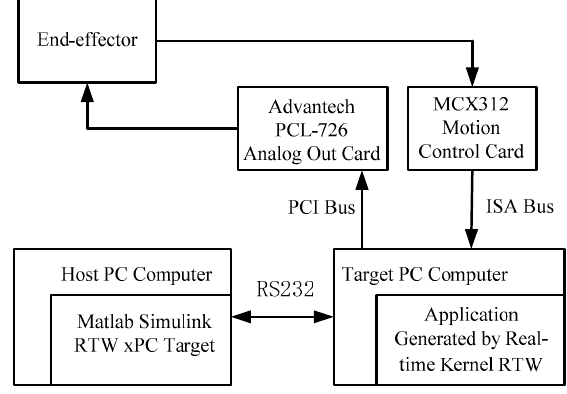
Figure 8. Real-Time Workshop (RT W) xPC target real-time control platform principle diagram.